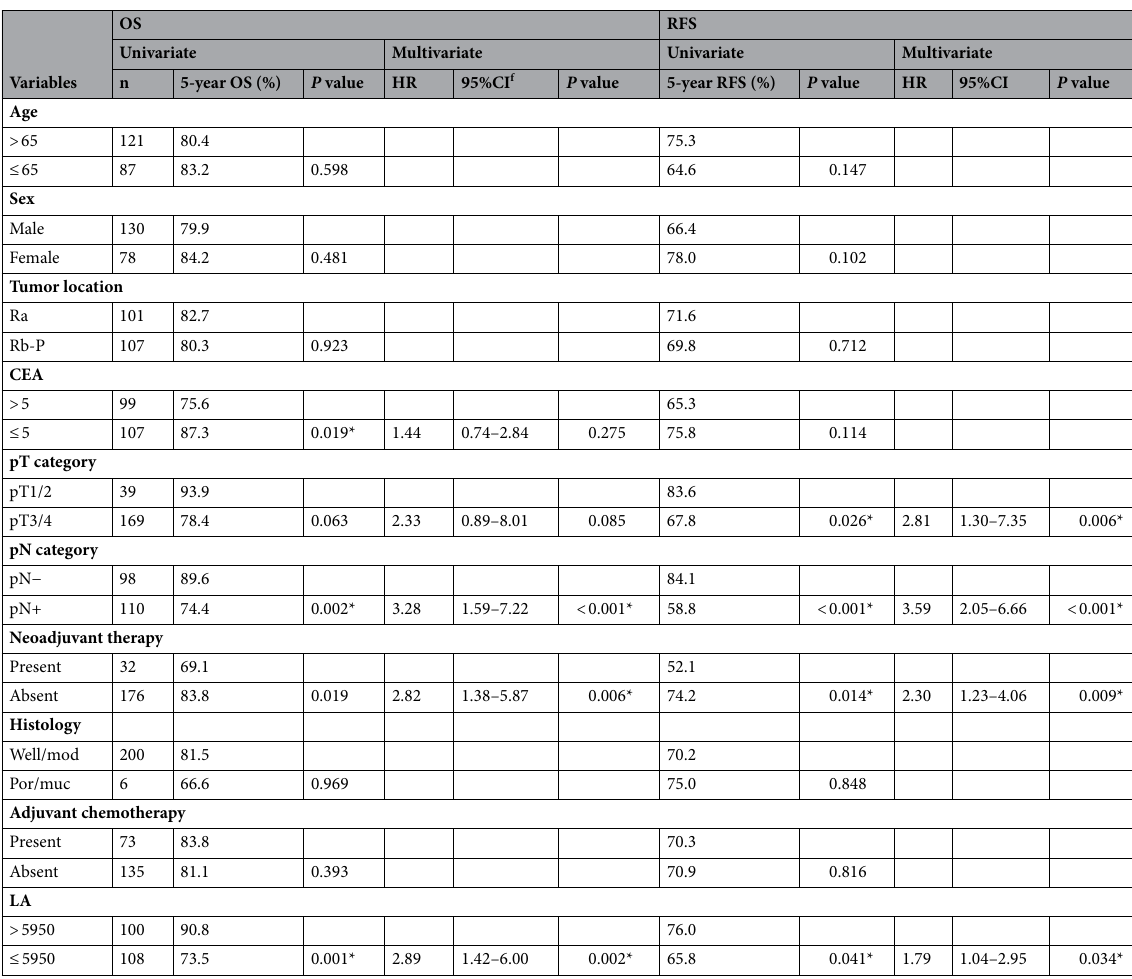
Table 4. Univariate and multivariate analysis using clinicopathological characteristics and LA for overall survival (OS) and recurrence-free survival (RFS) in the validation cohort. CEA carcinoembryonic antigen, well/mod well-differentiated/moderately-differentiated, por/muc poorly-differentiated/mucinous, LA lymphocyte × albumin, HR hazard ratio, CI confidence interval. * P <